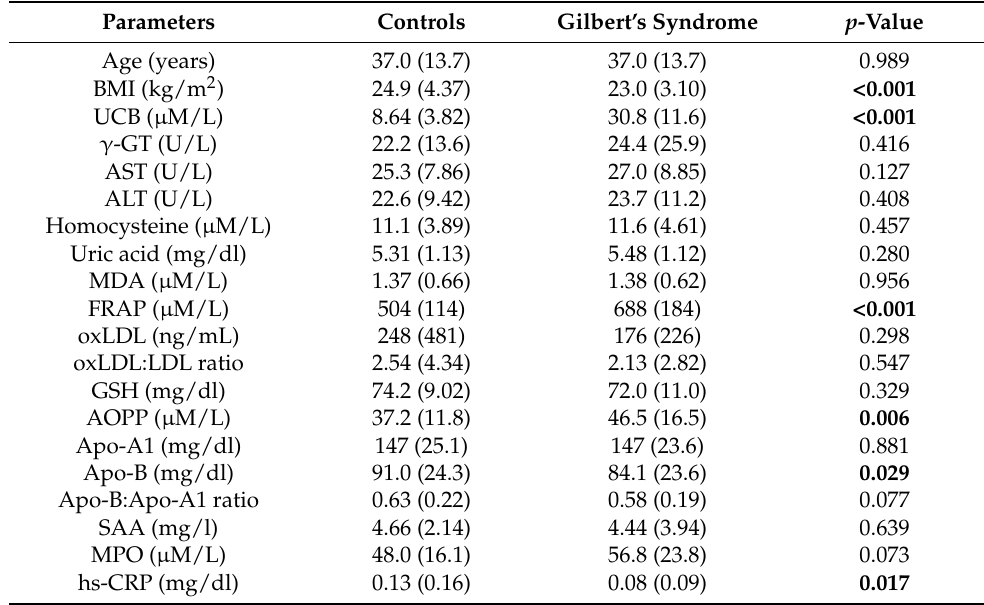
Table 1. Demographic features and biomarkers for oxidative stress and inflammation of individuals with GS ( n = 119) and controls ( n =